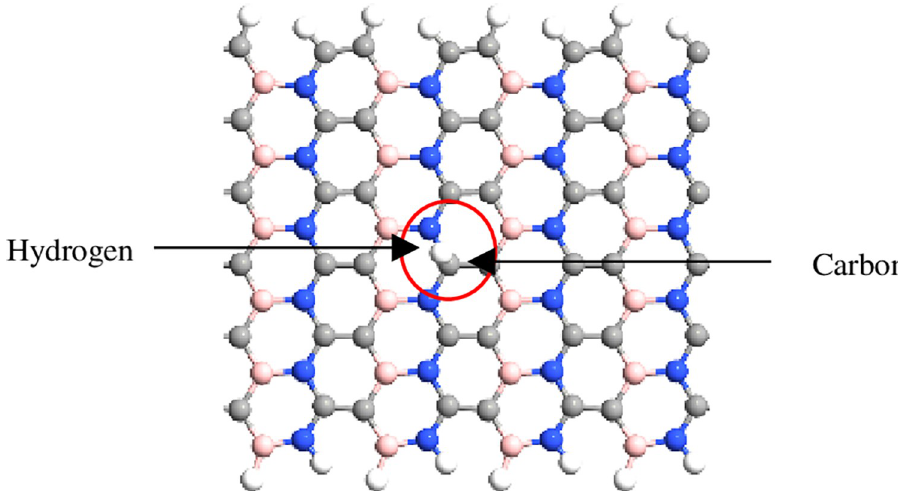
Fig 2. Optimized structures of 12-BC 2 NNR with different positions of H 2 gas molecules at carbon